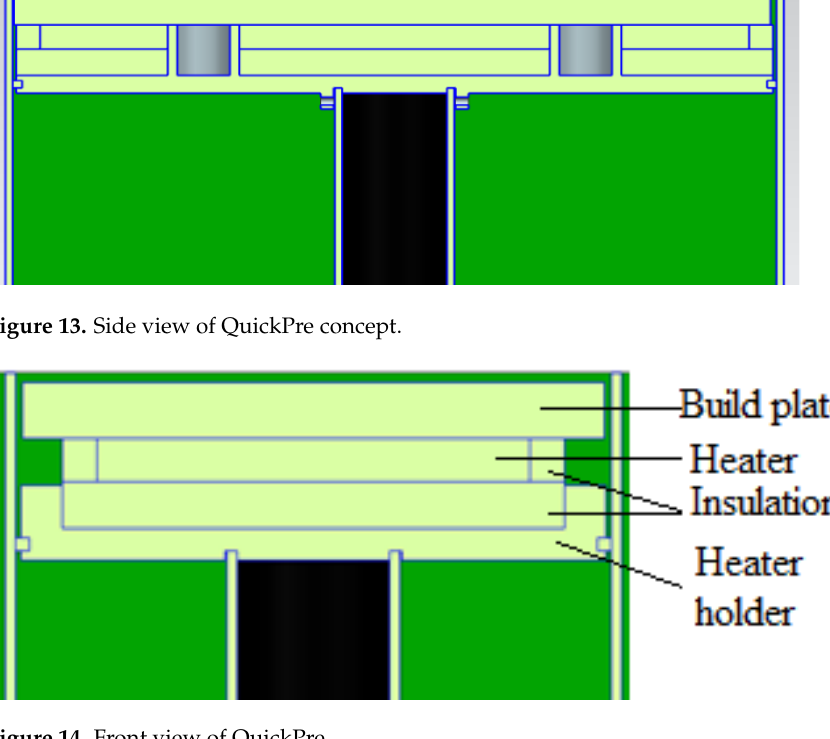
Figure 14. Front view of QuickPre.